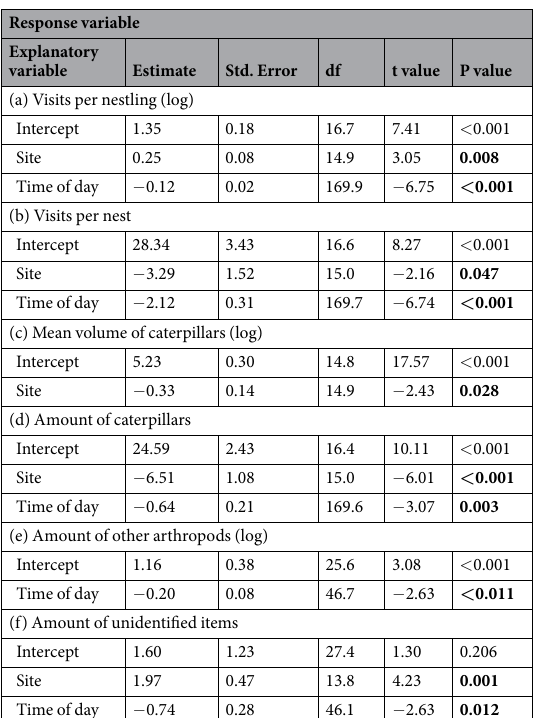
detected differences in caterpillar availability are expected to influence dietary provisioning, which largely depend on the immediate surrounding environment 31 . Nest video recordings and stable isotope analysis confirmed that the differences in food availability were indeed associated with differences in nestling diet. Nest video recordings revealed that blue tit nestlings in the forest site were fed almost exclusively caterpillars, whereas in the suburban and especially the urban site, they also received other arthropods and unidentified items, resulting in broader dietary input. Although we could not identify with absolute confidence the provisioning of anthropogenic items from our video-recordings, field observations and anecdotal evidence strongly suggest so. Some parents trapped in nestboxes carried fat-ball (Fig. S7), and at a nearby site in Scotland, peanuts were found lodged in gullets of dead nestling (Fig. S8; Gerald Lincoln, pers. observation). Cowie and Hinsley 43 also detailed for great tit nestlings that processing of human-provisioned items may be difficult for chicks. In addition, low